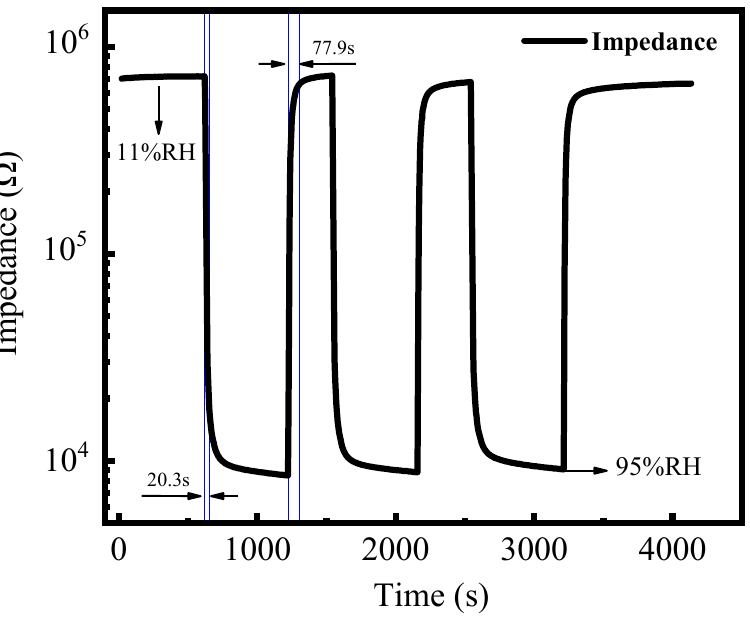
Figure 5. Dynamic response–recovery curves of RH sensitivity of the GO-based sensor at room temperature.